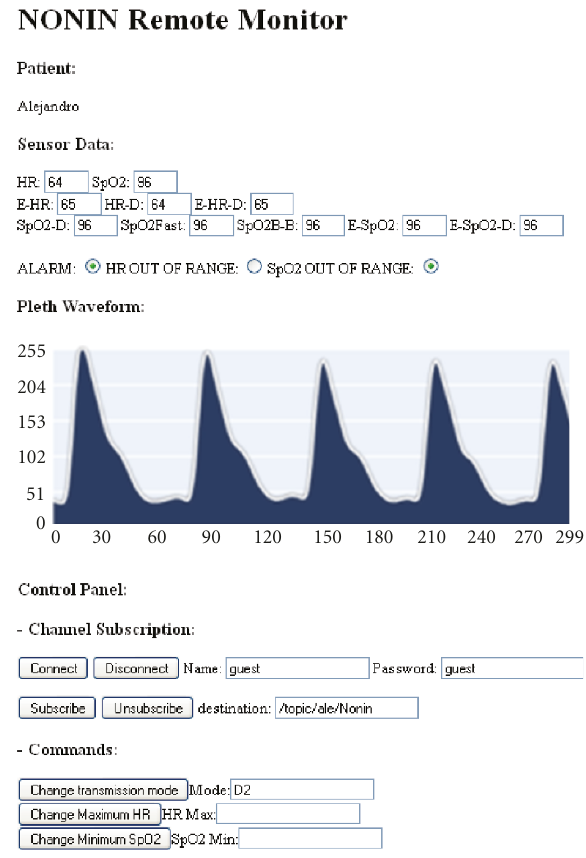
Figure 4: DHTML page